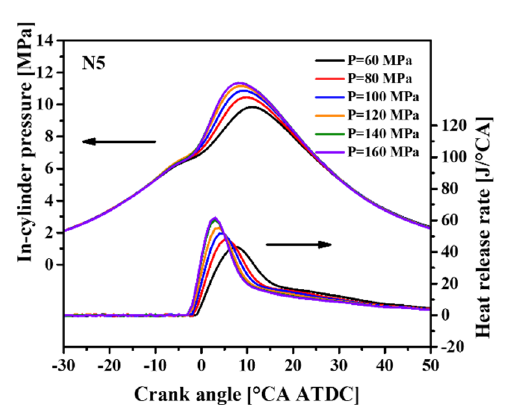
( b ) The in-cylinder pressure and heat release rate of N2.5 at different injection pressures.